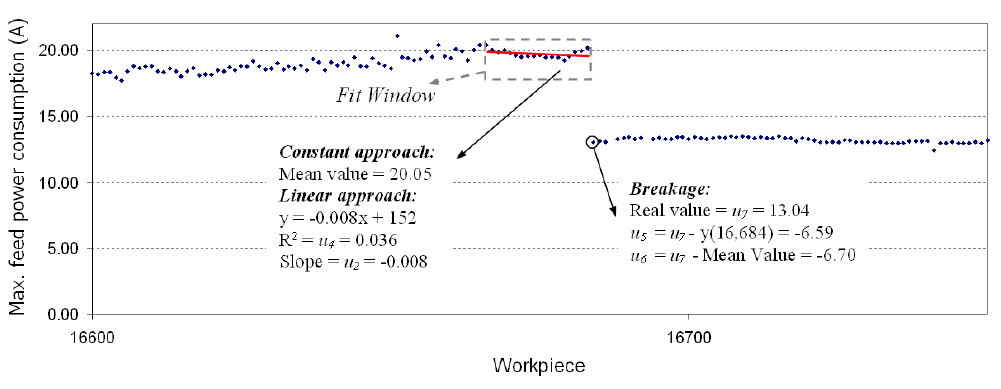
Figure 6. Two assumptions of electrical power consumption evolution: constant behaviour or linear